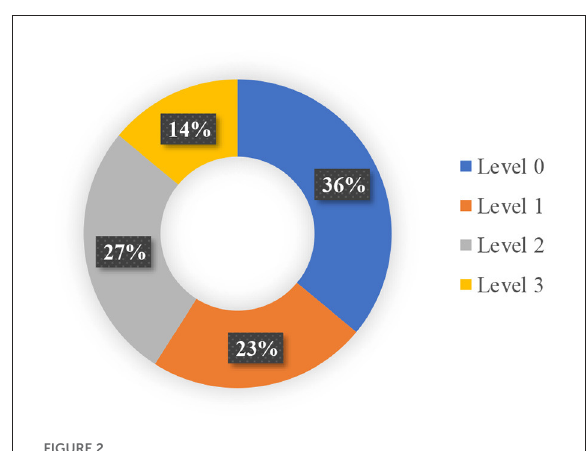
FIGURE2 The distribution of different rockburst